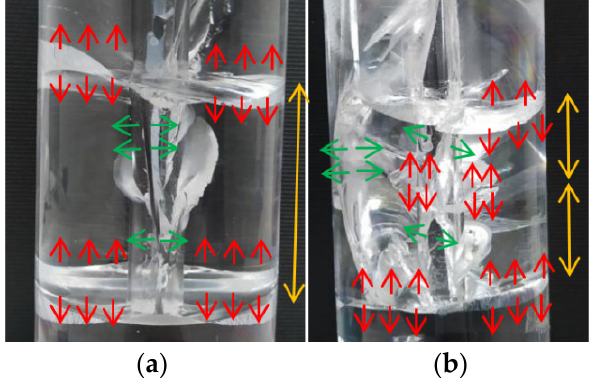
Figure 7. Crack morphology and driving thermal tensile stresses (yellow arrows are crack spacing, green arrows indicate the circumferential shrinkage of the vertical circumferential cracks, and red arrows indicate the longitudinal shrinkage of the horizontal radial plane cracks). ( a ) specimen 1; ( b ) specimen 2.